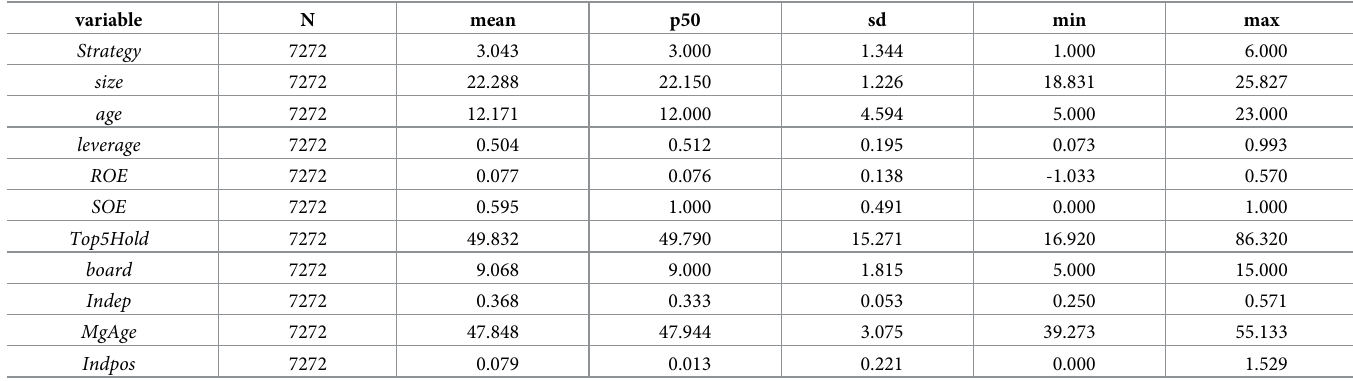
Table 2. Descriptive statistics.